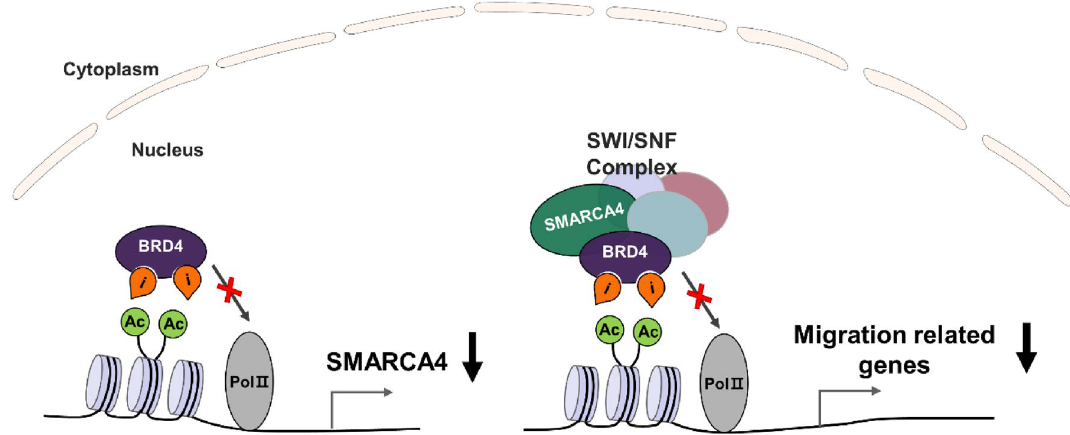
Figure 7. Schematic representation of SMARCA4 regulating cell migration by BET inhibitors. BRD4 and SMARCA4 have bromodomain to recognize histone acetylation and initiate transcription. SMARCA4 regulates transcription by binding to the acetyl residues of histone H3 and involves chromatin remodeling for gene expression by binding to BRD4 as an SWI/SNF